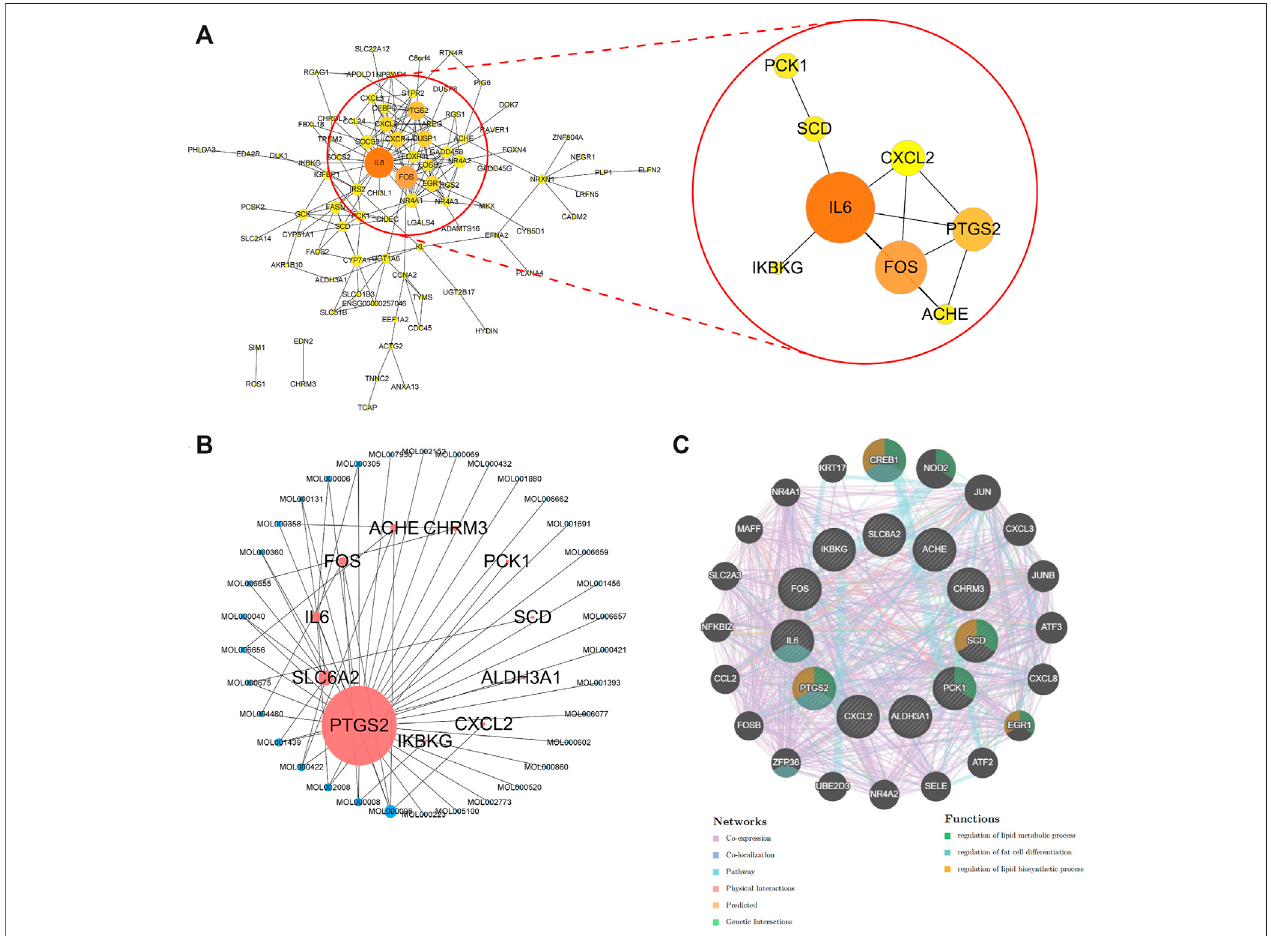
FIGURE 5| Protein-protein networkanalysis and topological analysis ofN&P. Protein-protein networkof core genes (A) wasgraphed by Cytoscape. The network of corresponding components from POL and core genes (N&P) (B) was graphed by Cytoscape. Pink node represented the core genes while blue represented the corresponding components. Node size is proportional to its degree. The larger the area is, the more important it is in the network. Topological network of N&P (C) was graphed by GeneMANIA. The different color lines represented the network relationships while the different color circles represented the gene functions.